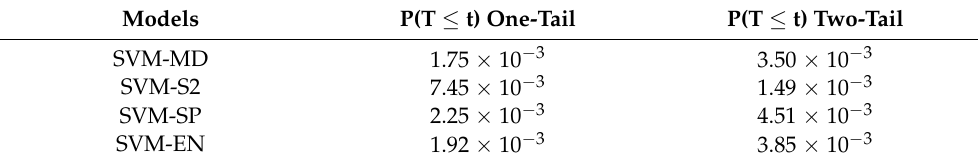
Table 7. t -test: basic SVM and enhanced SVMs sample for variance for simple beam.